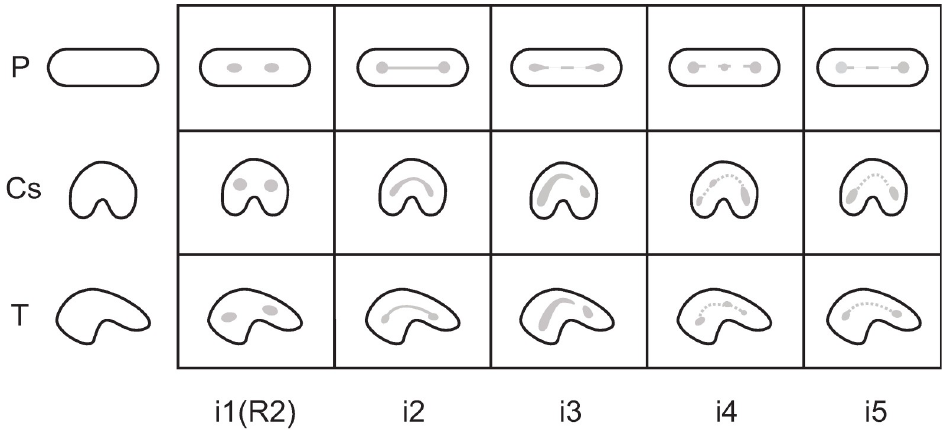
Fig 11. Combined isthmus classification system. Based on systems developed by Hsu and Kim [57] and Fan et al. [11]. Black is external root form and grey is canal form. P = plate-shaped, Cs = C-shaped, and T = Tomes’ root.